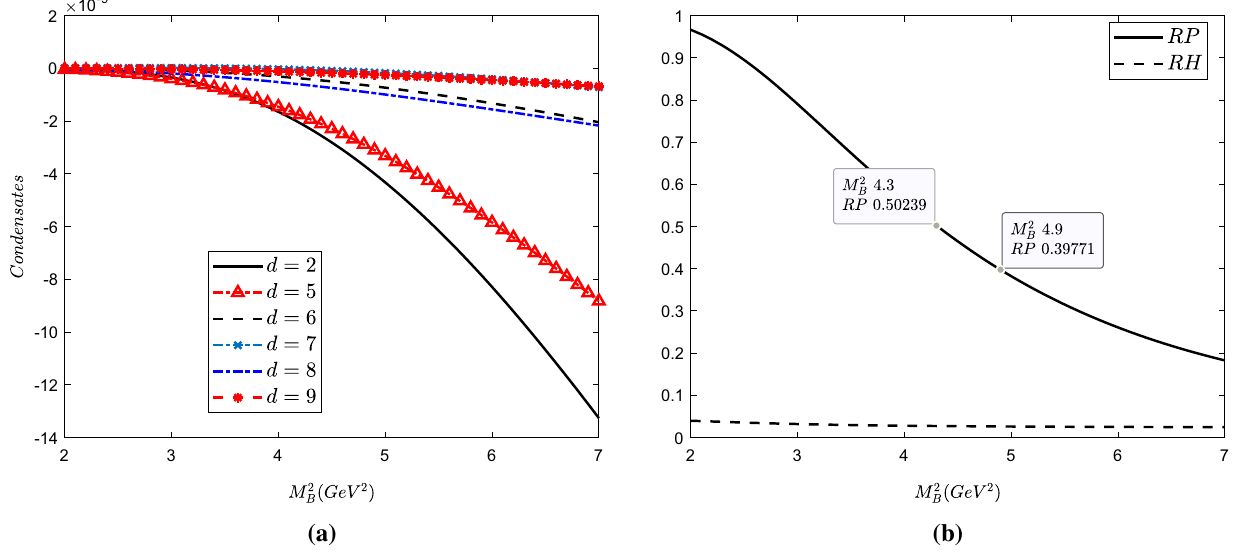
Fig. 1 a denotes the various condensates as functions of M 2